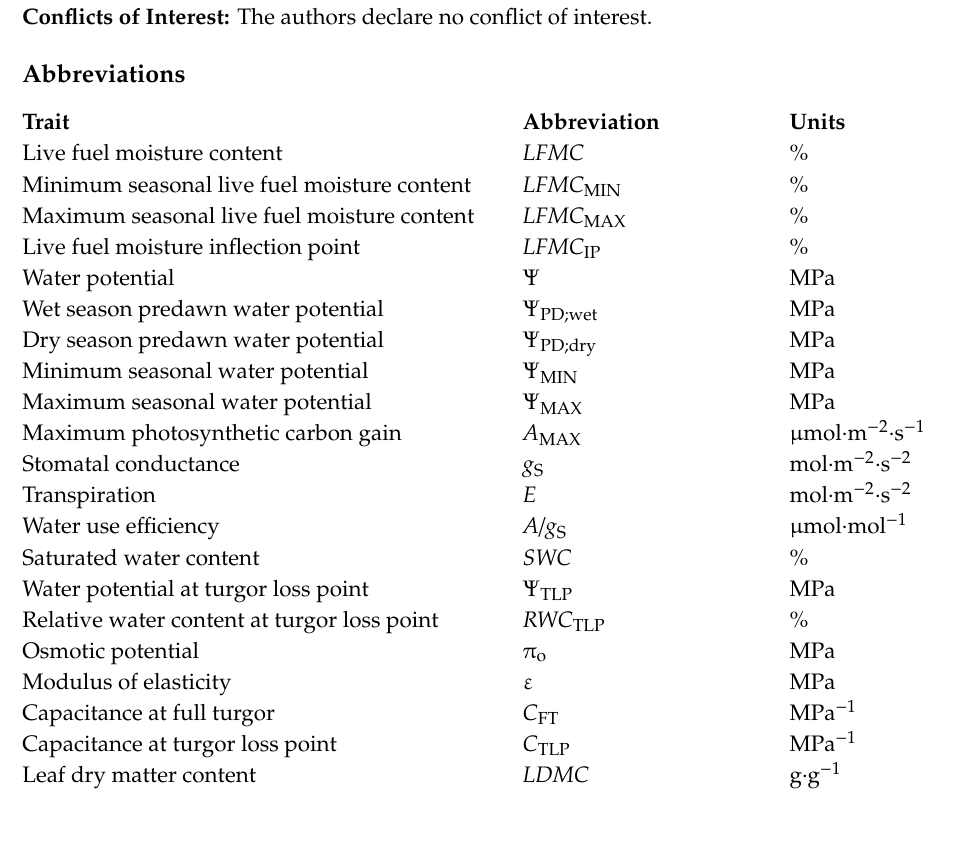
Figure S1: Water potential versus live fuel moisture content for 11 species, measured at the Stunt Ranch Santa Monica Mountains Reserve, with the piecewise linear regression used to determine the inflection